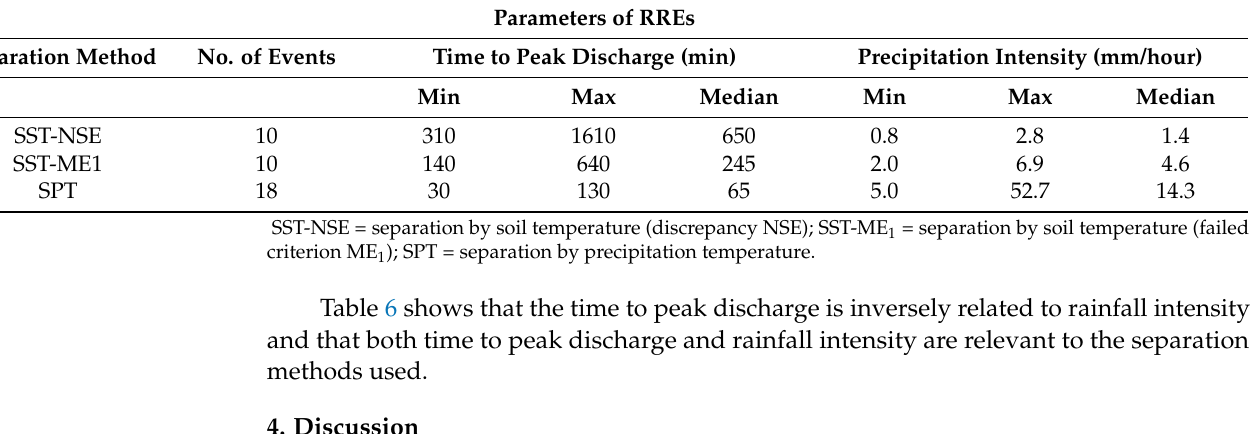
Table 6. Time to peak discharge and precipitation intensity relative to the separation method. Parameters of